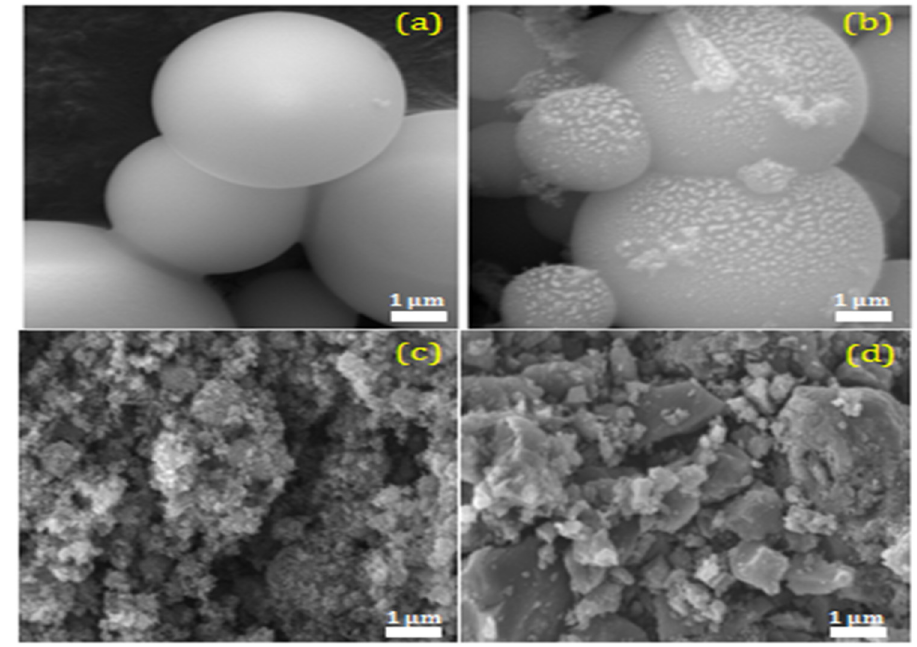
Figure 9: SEM images: ( a ) SBA - 15, ( b ) 1Pd – 1Cu/SBA - 15, ( c ) TiO 2 , and ( d ) AC.